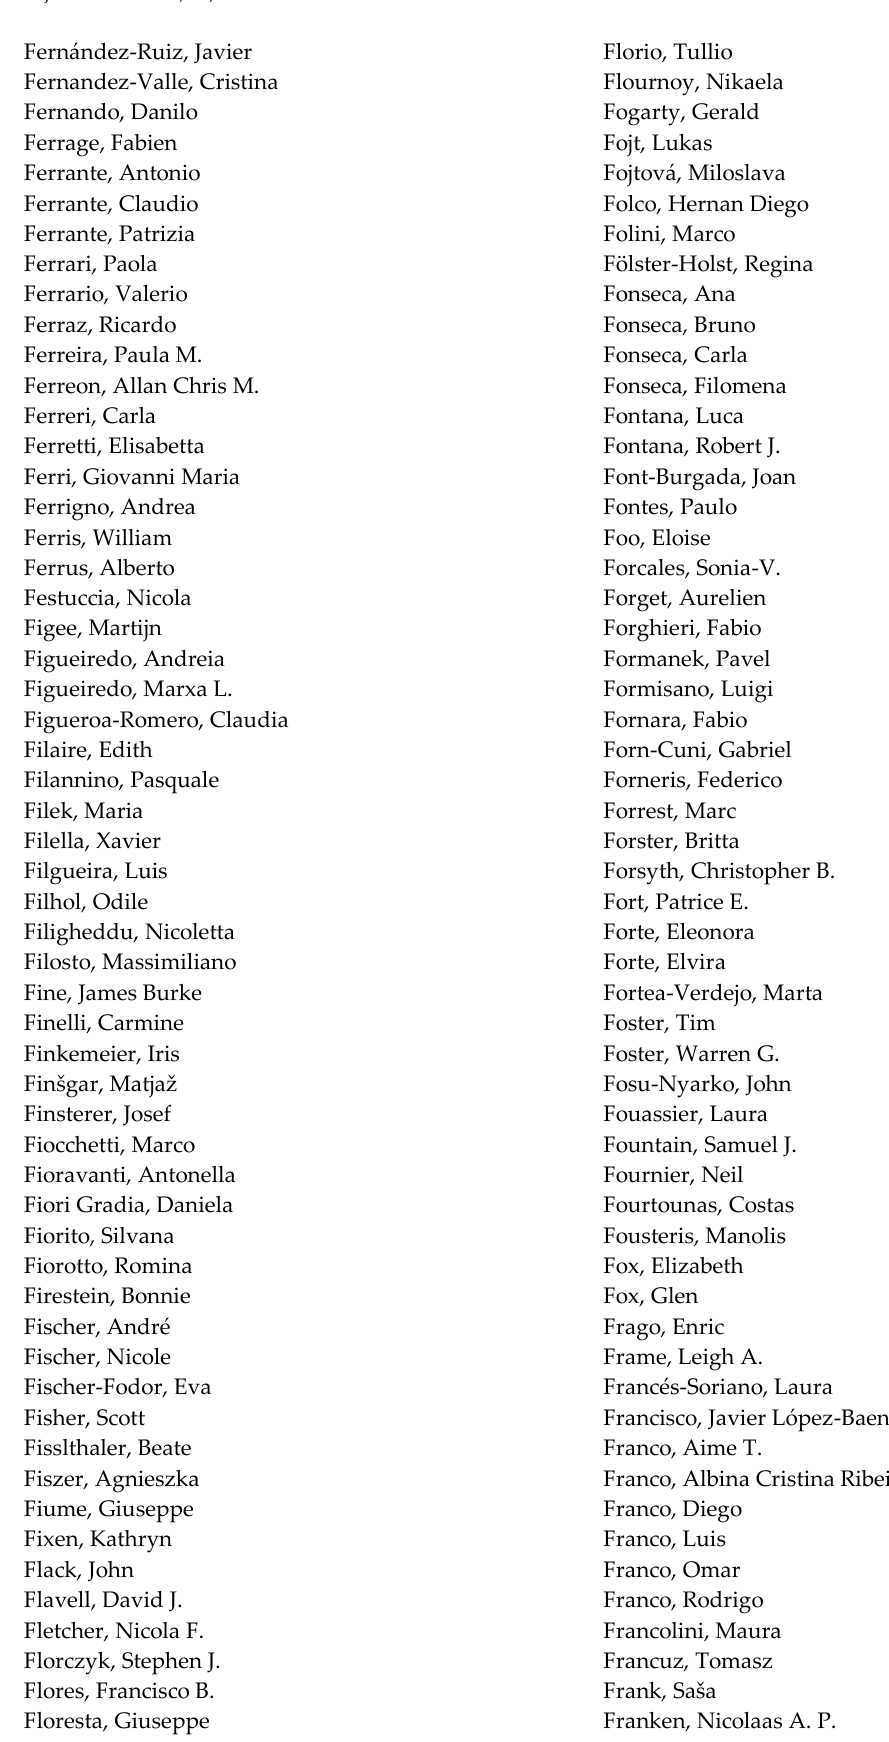
Figueiredo, Andreia Figueiredo, Marxa L. Figueroa-Romero,